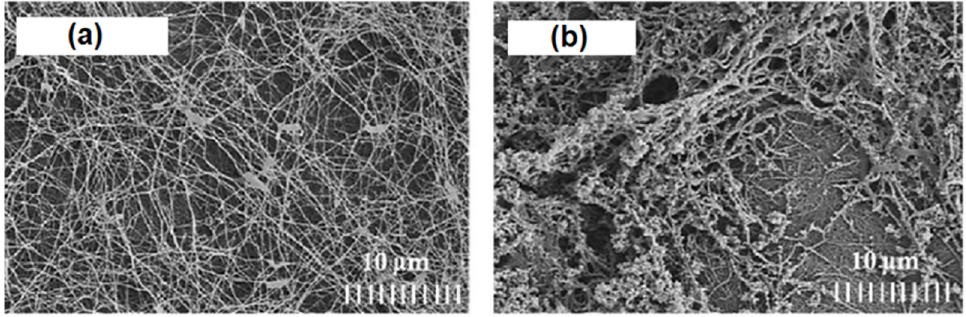
Figure 10. SEM micrograph of ( a ) bacterial cellulose; ( b ) PANI/BC composite. Reprinted with per- mission from [129]. Copyright 2018,